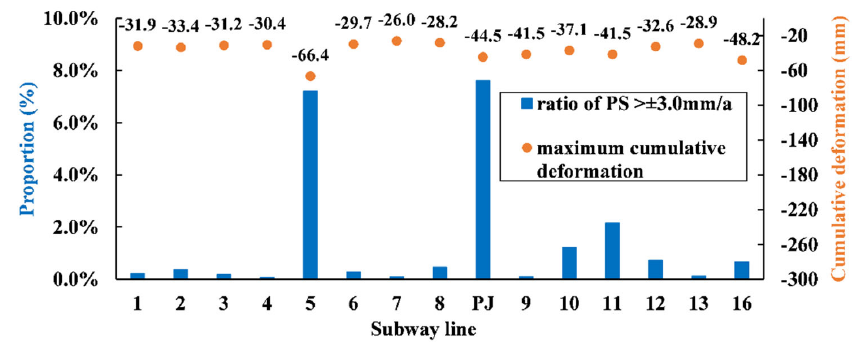
Figure 8. Proportion of PS points (>± 3.0mm/a) and maximum cumulative deformation along sub- way lines from 2013 to 2020. subway lines from 2013 to